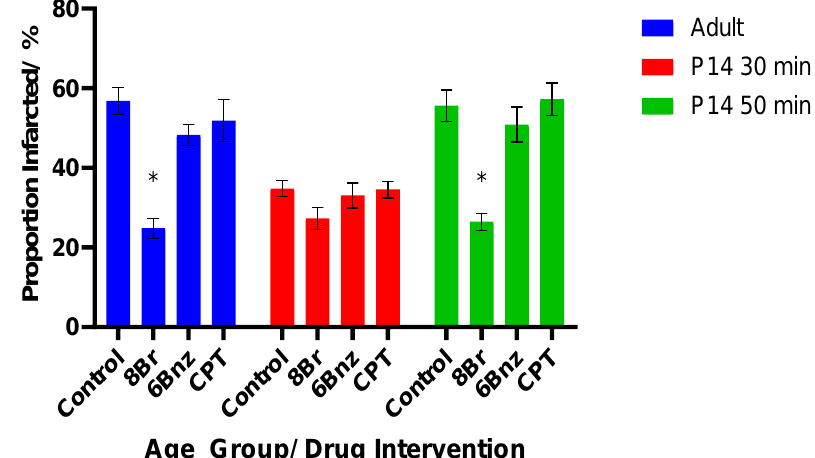
Figure 4. Cross-sectional proportionate infarct size vs. age group and intervention. Mean ± SE; * = p < 0.05 vs. same age group control. Two separate P14 groups were used with different ischaemic durations (see text). Statistical testing by Student’s t -test compared against same age group control. n = 6 per group.